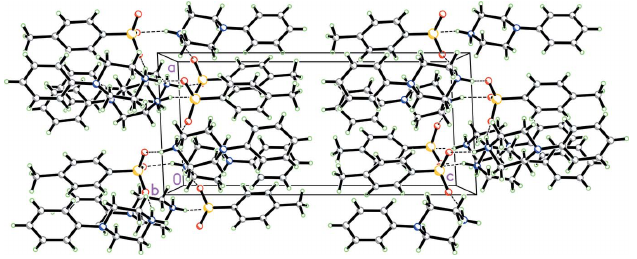
Figure 25 Packing diagram for 10 viewed down the b axis showing the three- dimensional network of N—H (cid:2)(cid:2)(cid:2) O hydrogen bonds involving phenyl- piperazinium cations and tosylate anions, which arrange the ions such that there are hydrophilic and hydrophobic (110) planes in the a -axis direction. molecule of crystallization. Multiple N—H (cid:2) (cid:2) (cid:2) O and O— H (cid:2) (cid:2) (cid:2) O hydrogen-bonding interactions combine to form a